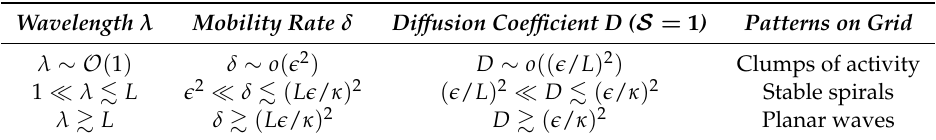
Table 1. Spatio-temporal patterns emerging in three different regimes, at low (i), intermediate (ii) and high (iii) mobility